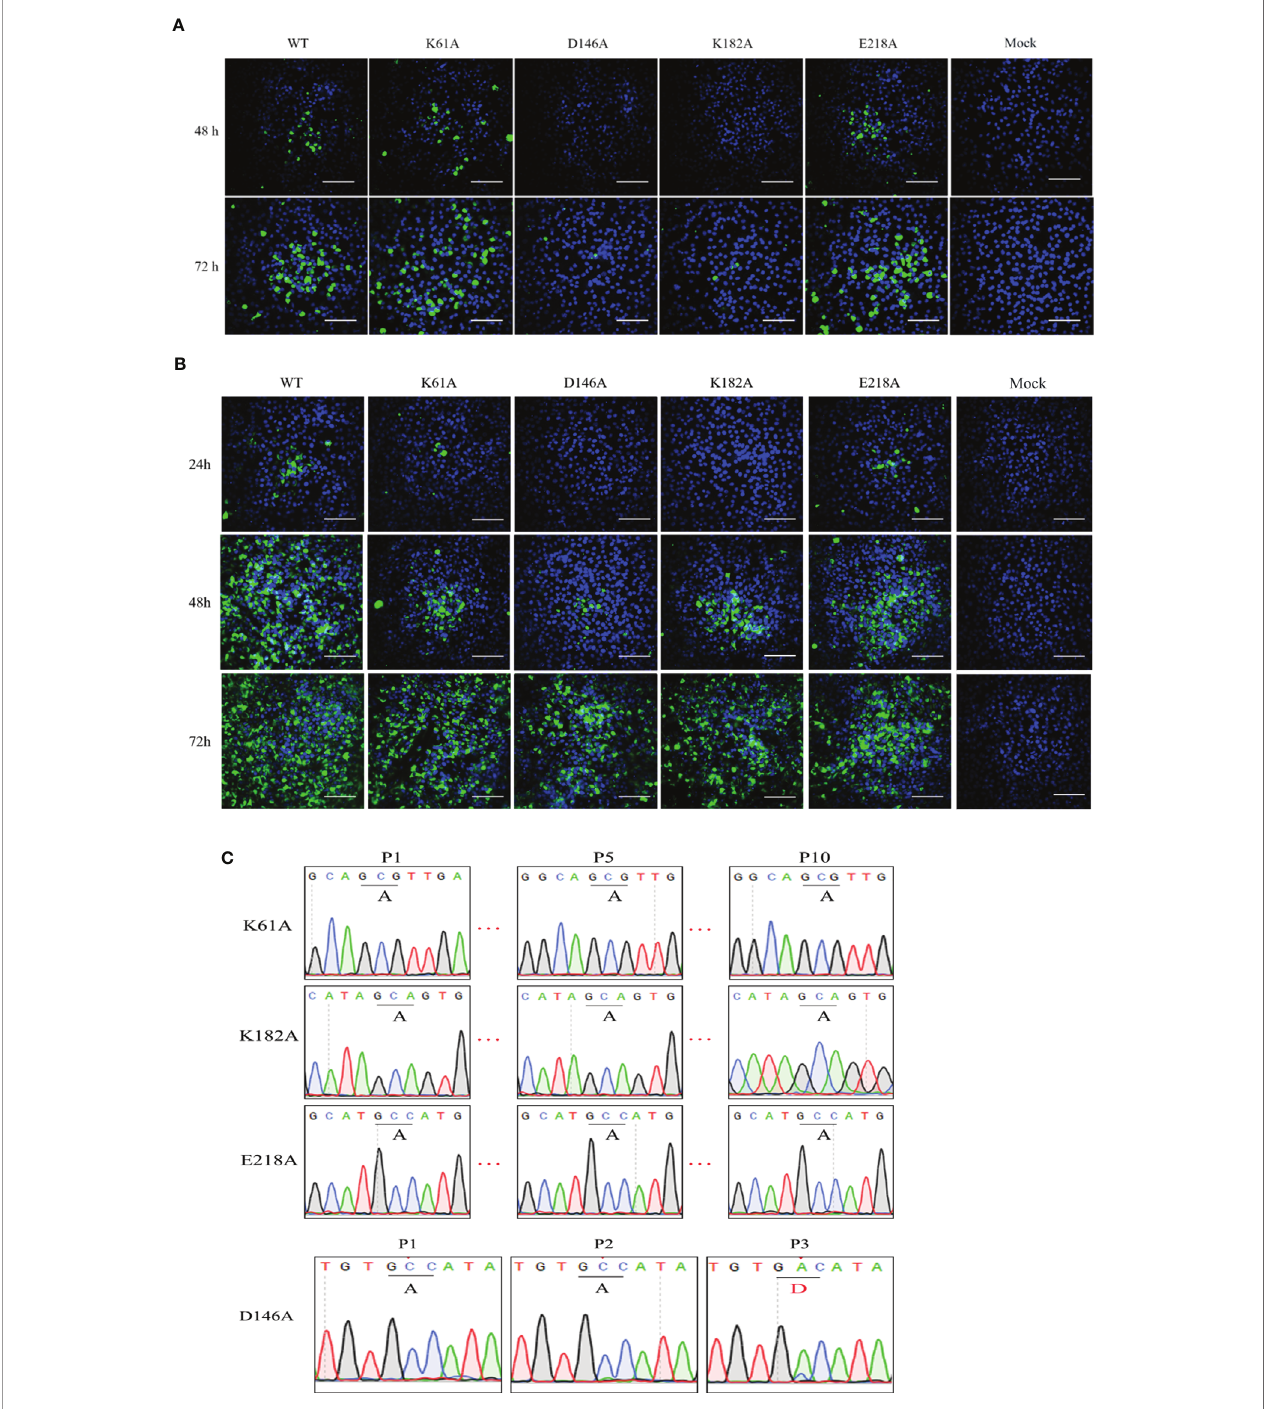
FIGURE 2 | Recovery and characterization of K-D-K-E mutant TMUV. (A, B) BHK-21 cells were transfected with equal amounts of genome-length RNA transcripts (A) or infected with passage 1 (P1) viruses (B) and subjected to IFA using anti-TMUV E protein MAb at the indicated time. (C) The genomes of different passages of viruses were sequenced to analyze genetic